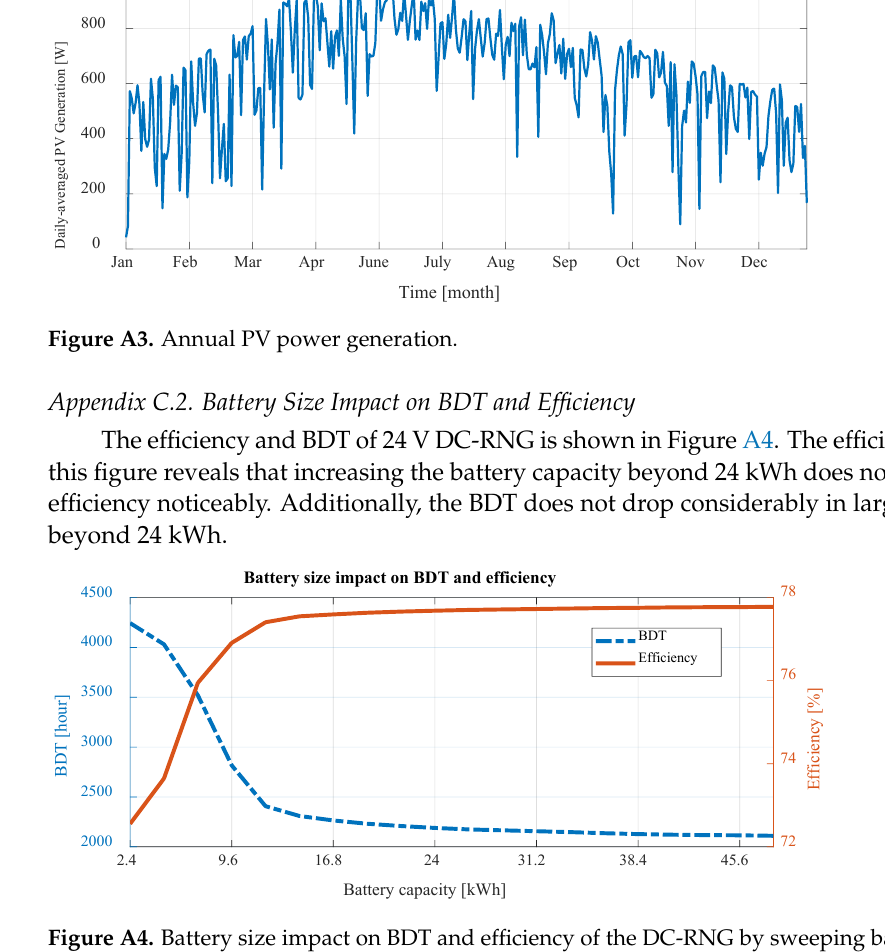
Figure A4. Battery size impact on BDT and efficiency of the DC-RNG by sweeping battery capacity from 2.4 kWh to 48 kWh.